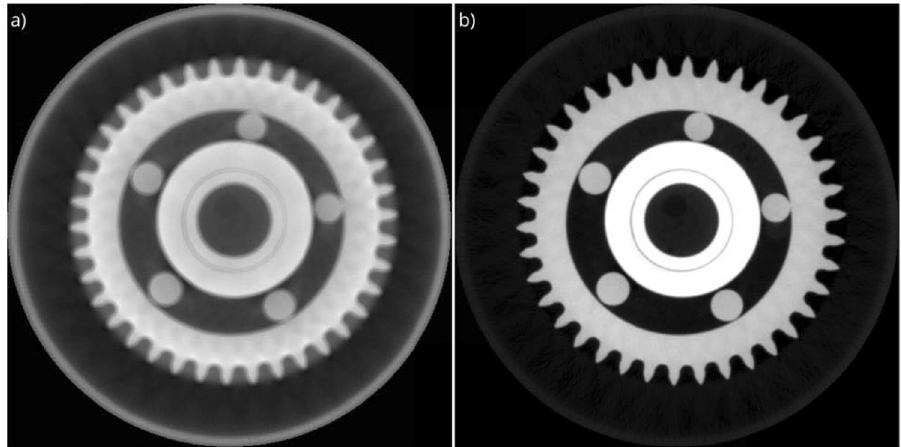
Figure 3. The reconstruction results of the ball bearing using the customized reconstruction software: ( a ) The image is reconstructed using the standard FDK algorithm. ( b ) The image is reconstructed using the FDK algorithm with the proposed correction methodology.